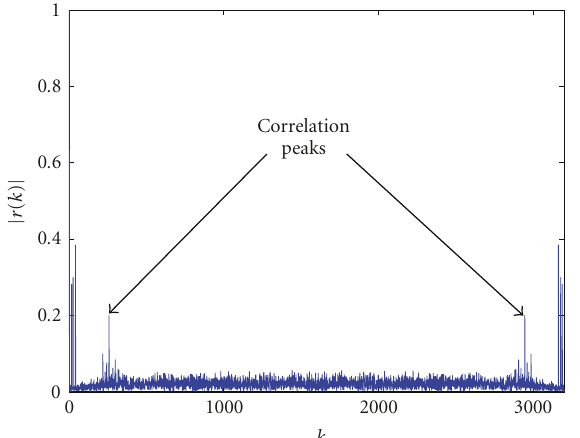
Figure 6: Autocorrelation of a CP-OFDM signal through SUI-4 channel model with AWGN at SNR = 0 dB.